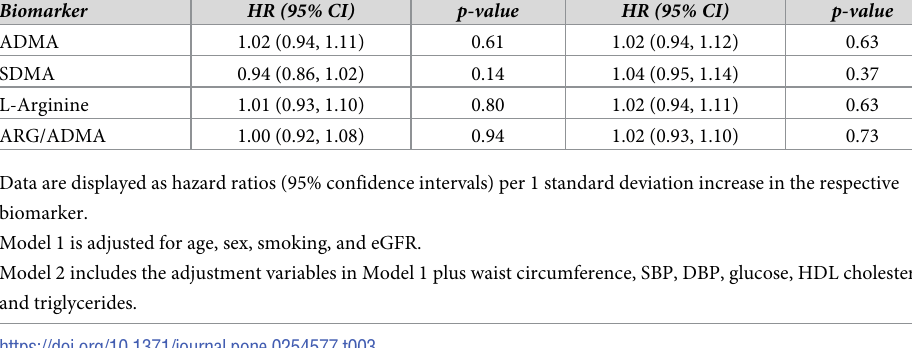
Table 3. Association of biomarkers with incident metabolic syndrome.